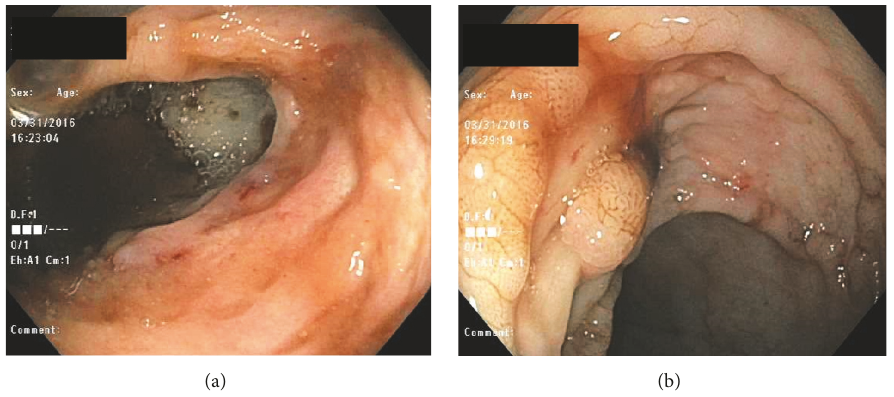
Figure 3: Second colonoscopy: (a) cecal ulcer and (b) transverse colon